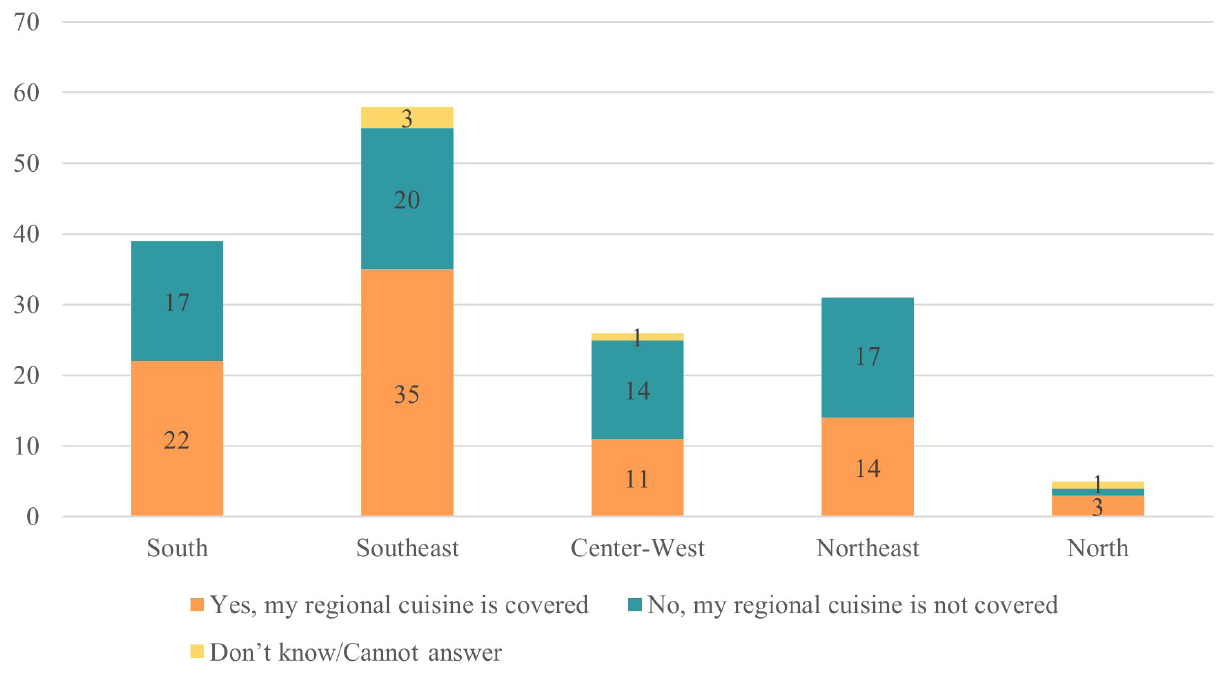
Figure 2. Perception of patients with PKU, their family members, and caregivers regarding the addition of foods typical to the region of Brazil in which they live to the Phe content of food tables available in the literature